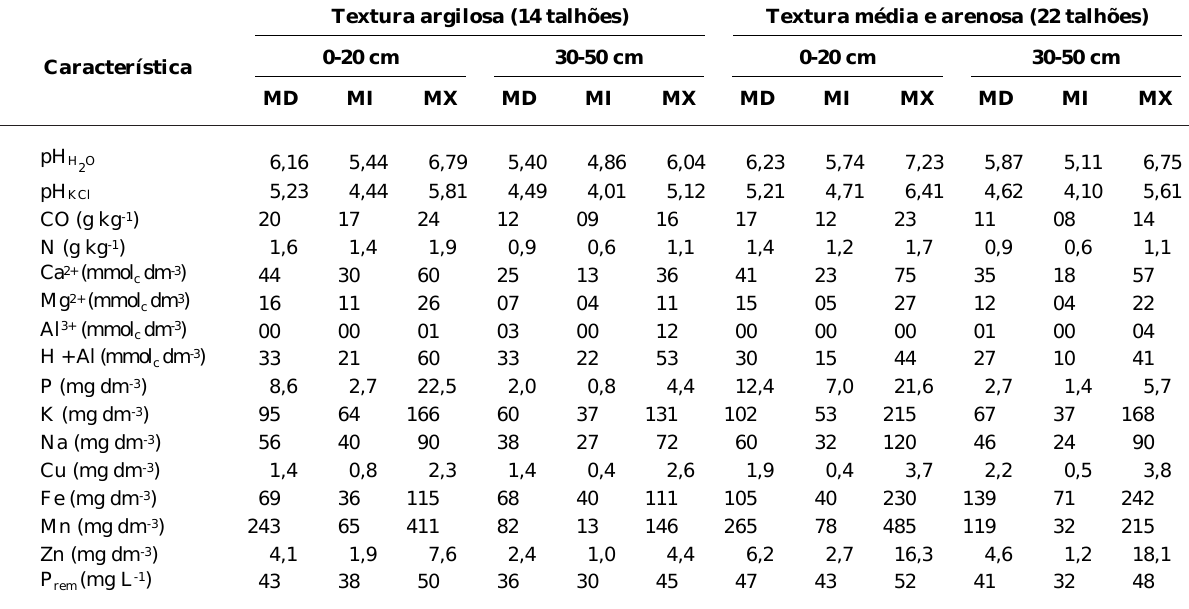
Quadro 1. Valores médios (MD), mínimos (MI) e máximos (MX) das características químicas (1) de solos de diferentes texturas, em duas profundidades, de 36 talhões no ano de 1995